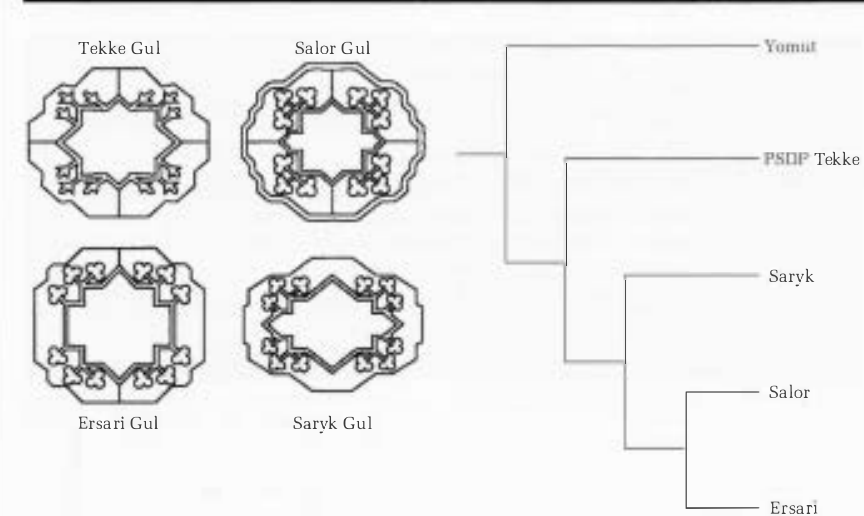
Figure 1 AHRC CECD post-doe famie Tehrani's PhD research investigated the evolution of material culture diversity in tribal populations of western Central Asia. He uses phyla­ genetic methods to analyze variations in textile-weaving techniques and motifs (such as the examples shown on the left} to reconstruct the descent of these groups' craft traditions from common ancestral assemblages (represented by the tree diagram on the right).